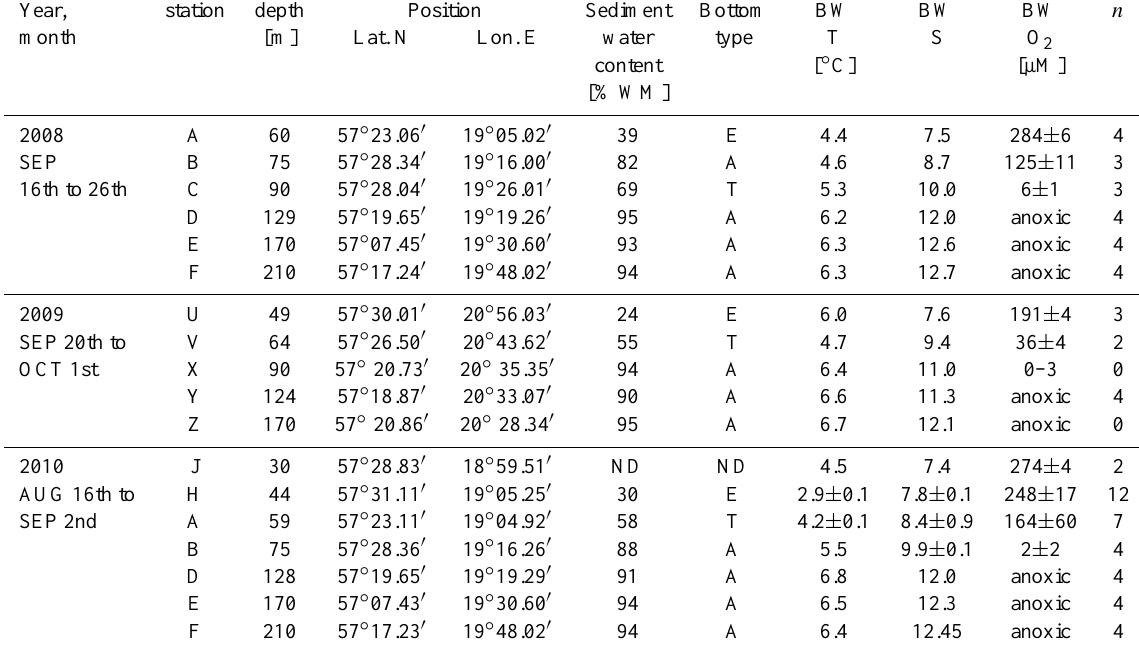
Table 1. Description of stations. The water content is the mass percent in the uppermost centimetre of the sediment. The bottom types A, T and E refers to Accumulation, Transportation and Erosion bottoms, respectively (H˚akanson and Jansson, 2002). Temperature and salinity were measured in ambient bottom water (BW); averages are shown when more than one deployment was made at the same station. The bottom water O 2 concentration, in µM, was measured approximately 10–20cm above bottom with an optode inside each chamber just before start of incubation (except at stations X and Z, where it was measured with a Seabird SBE 911 sensor on the CTD); the values given are mean values from 2–12 chambers depending on how many deployments were made at the same station the same year; the number of chambers used are given in the last column, n . ND means no sediment coring in 2010 at the station